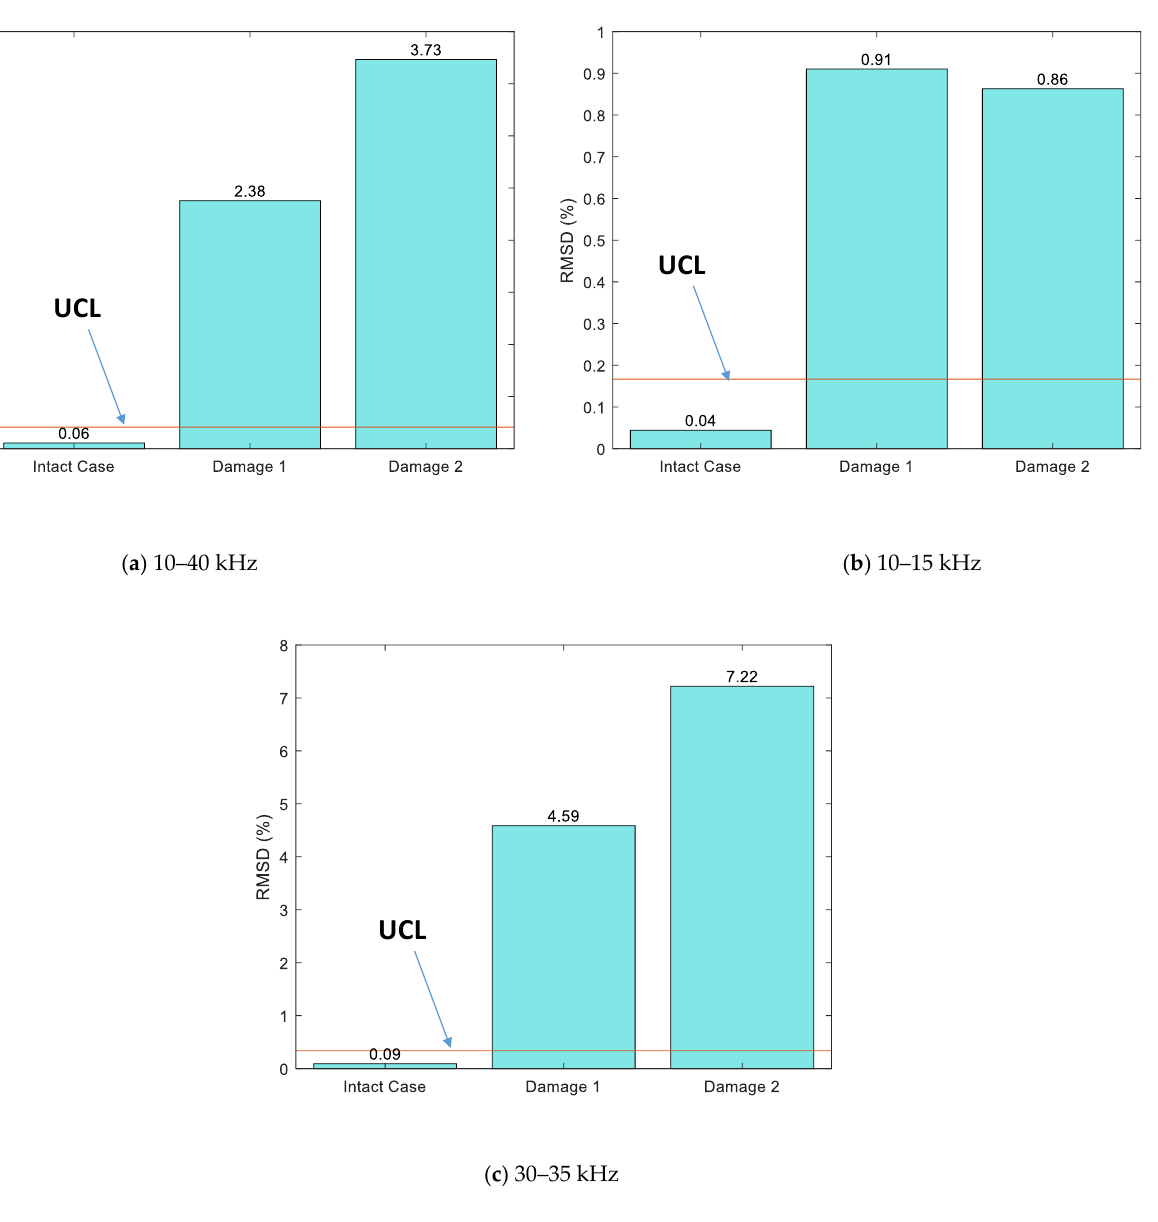
Figure 12. RMSD metric of measured admittance response under damage cases: damage close to the transducer (the second test scenario).